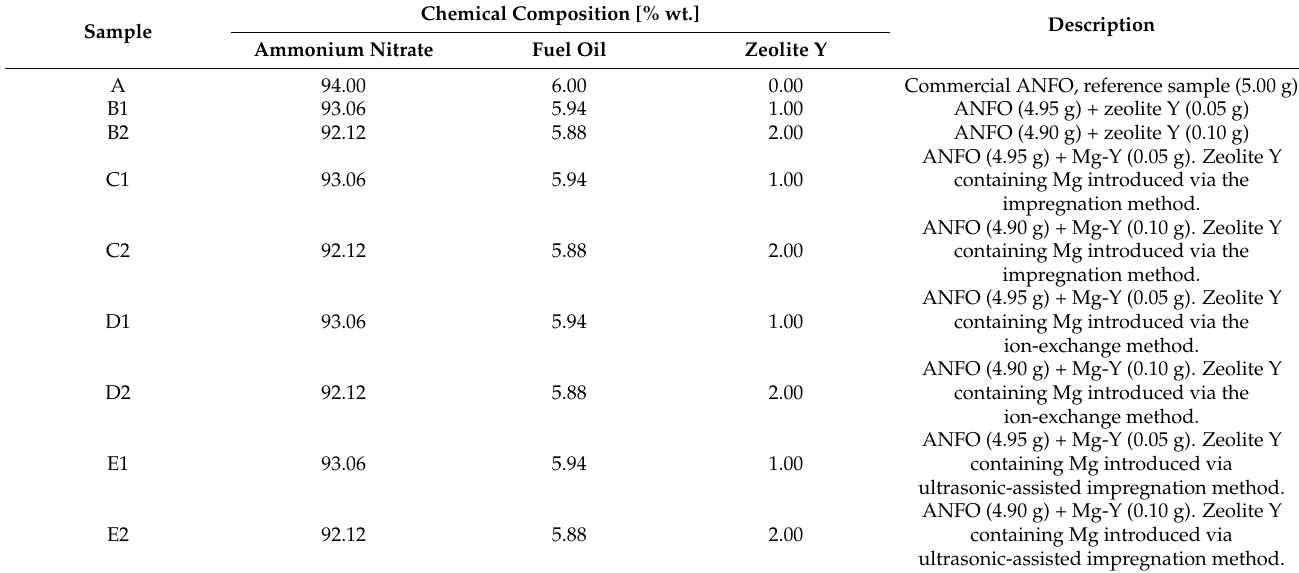
Table 1. Chemical composition of non-ideal explosives and their synthesis conditions. The total sample mass was normalized to 5.00